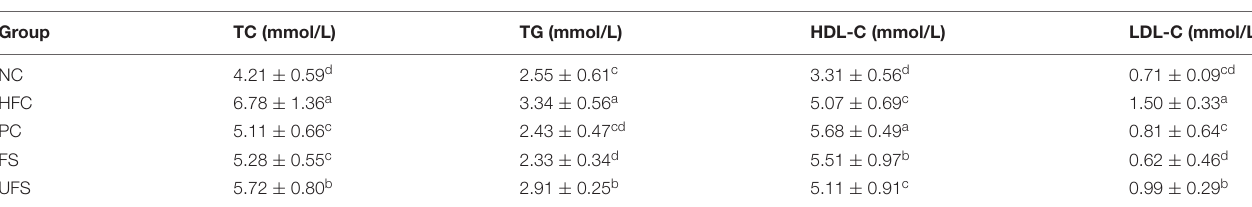
fermented seaweed extracts; UFS, unfermented seaweed extracts. TABLE 4 | Serum lipid profiles of five groups of